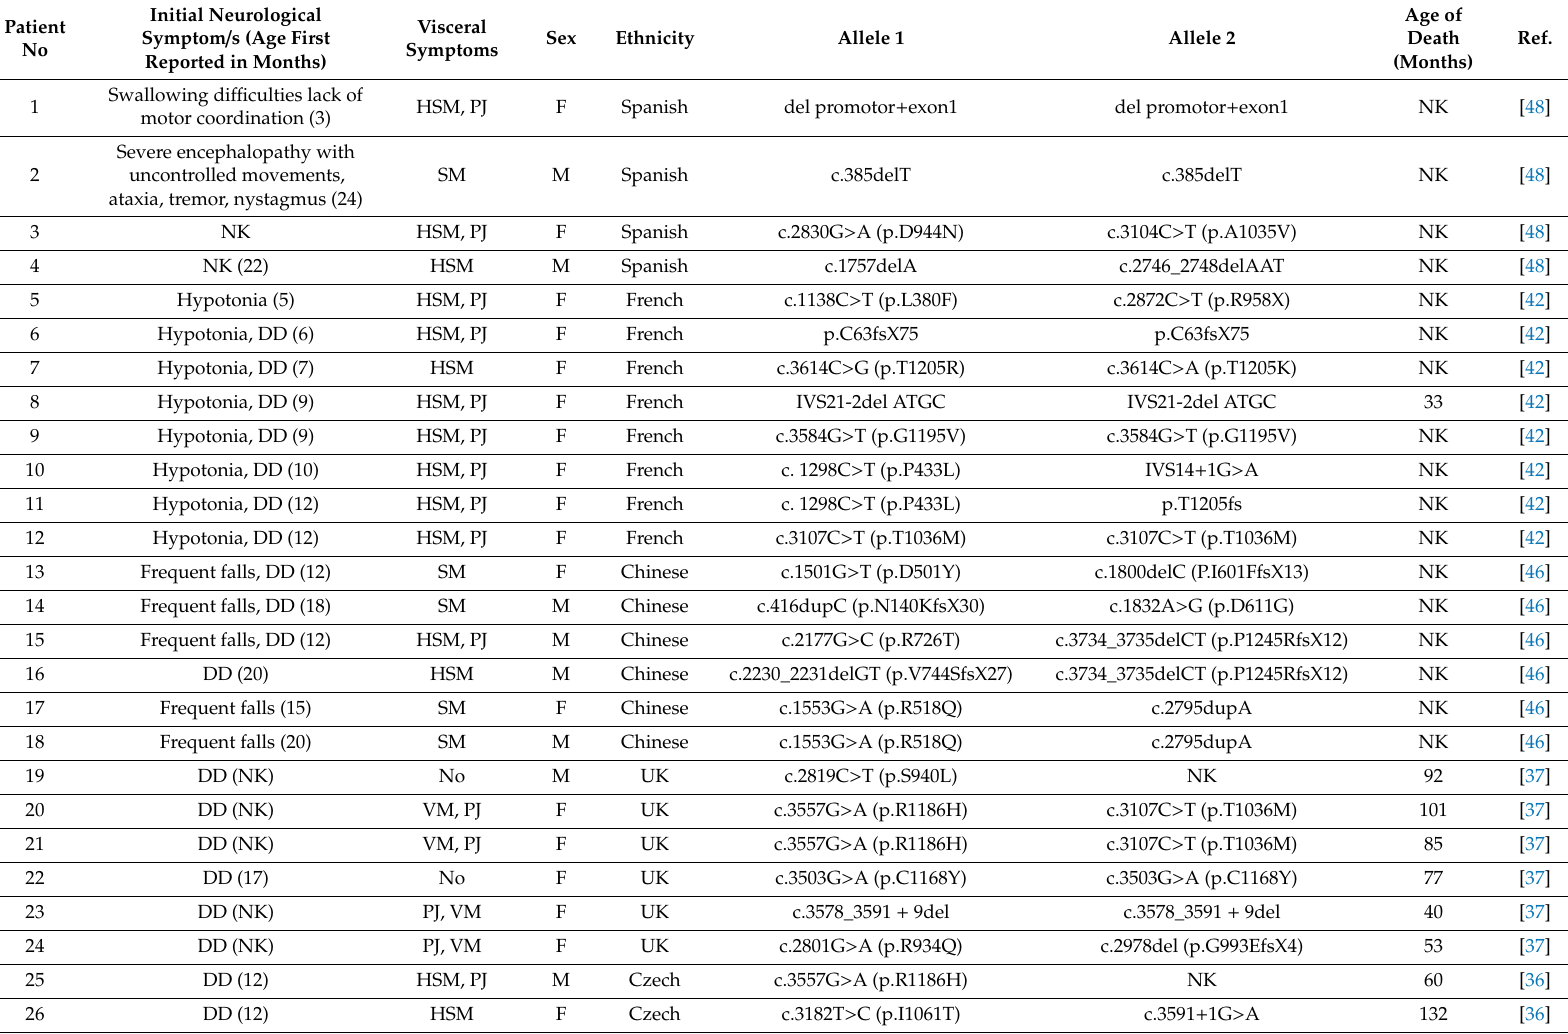
Table 2. Demographic, clinical, and molecular features of early infantile neurological onset disease with NPC1